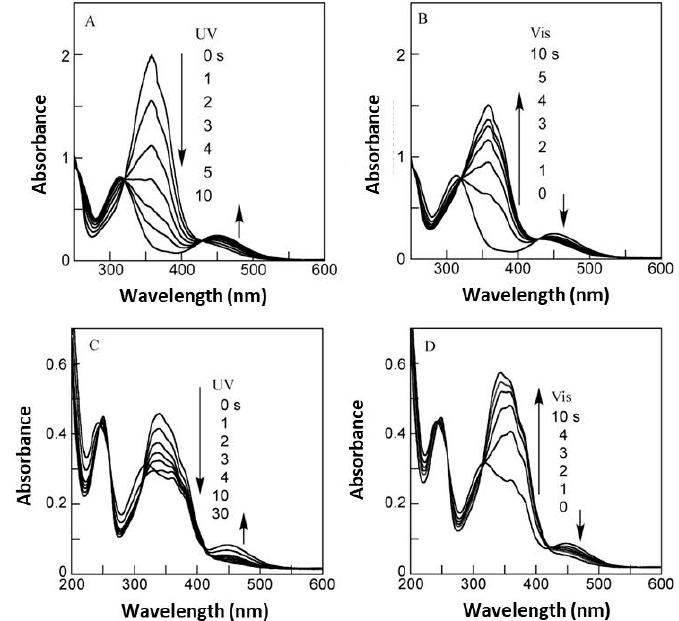
Figure 6. Changes in the absorption spectra of azo-functionalized liquid crystal polymer with six of the methylene spacer length (P6Az) in chloroform solution ( A , B ) and solid film ( C , D ) by irradiation of UV light (365 nm, 10 mW / cm 2 ) ( A , C ) and following visible light (436 nm, 58 mW / cm 2 ) ( B , D ). Source: Yagi et al. 2014 [42]. Copyright 2014. Reprinted with permission from Elsevier